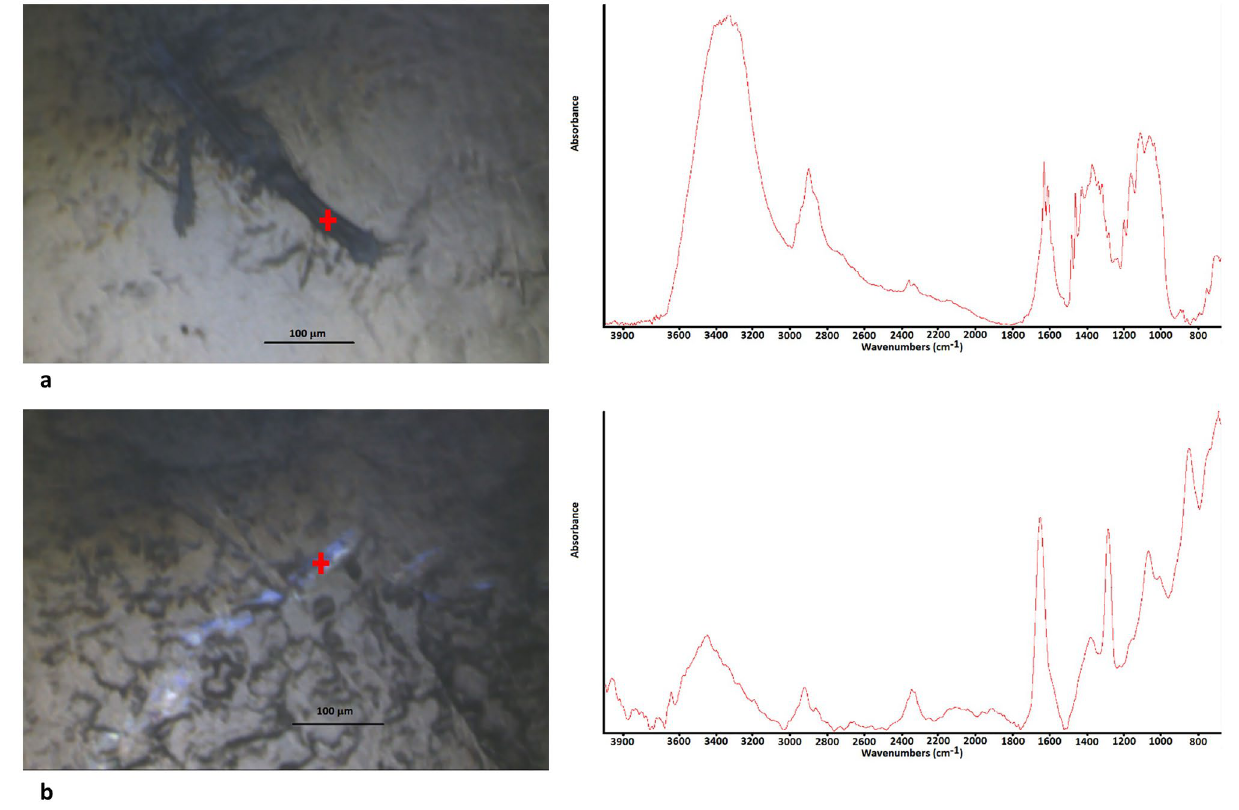
Figure 2. FTIR microspectroscopy of microfiber on KBr disc: ( a ) the microfiber with irregular shape and termination was of cellulosic nature; ( b ) the coloured microfibers with regular diameter was of polyamide